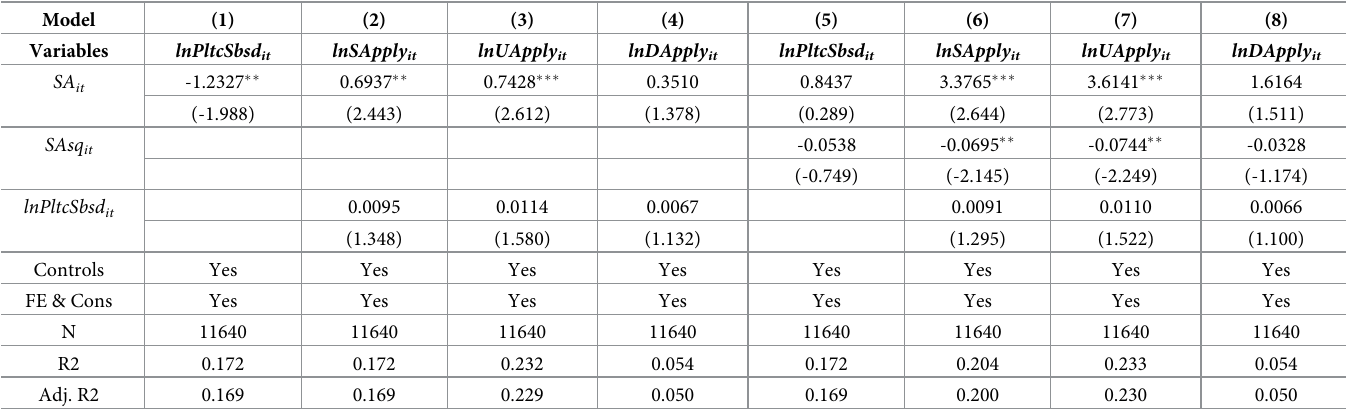
Table 6. Subsample results of exploitative innovation strategy. Model